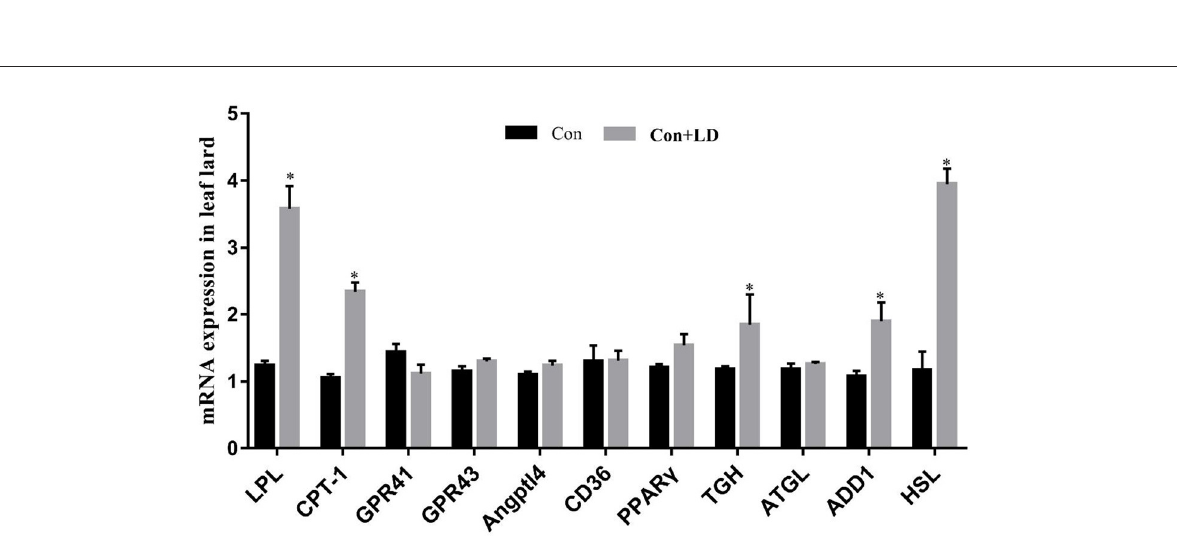
FIGURE7 Gene expression related to lipid metabolism in leaf lard of growing-finishing pigs. Values for histogram are shown as Mean ± SEM, * P < 0.05. LPL , Lipoprotein lipase; CPT1 , Carnitine palmitoyltransferase 1; GPR41 , G protein-coupled receptor41; GPR43 , G protein-coupled receptor43; Angptl4 , Angiopoietin-like protein 4; CD36 , Cluster of differentiation 36; PPAR γ , Peroxidase proliferative receptor γ ; TGH , Triglyceride hydrolase; ATGL , Adipose triglyceride lipase; ADD1 , Adipocyte determination and differentiation-dependent factor 1; HSL , Hormone sensitive lipase; Con, basal diet; Con + LD, basal diet + 0.1 % L. delbrueckii